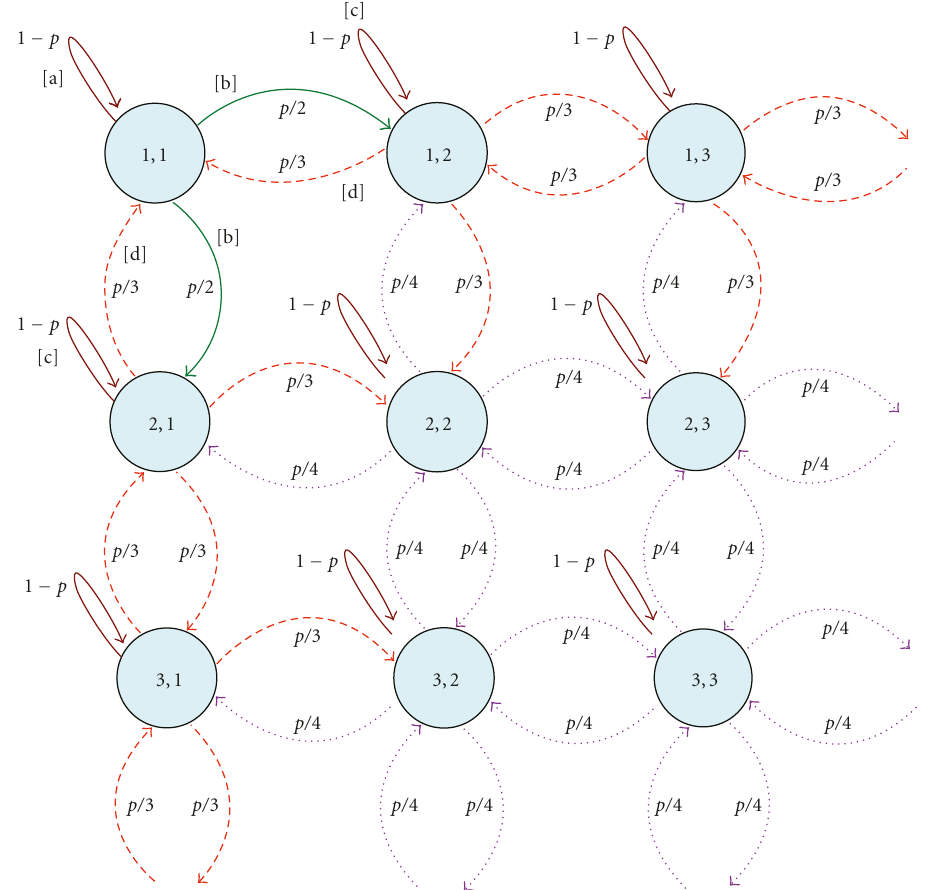
Figure 5: State transition diagram (partial) of the Markovian